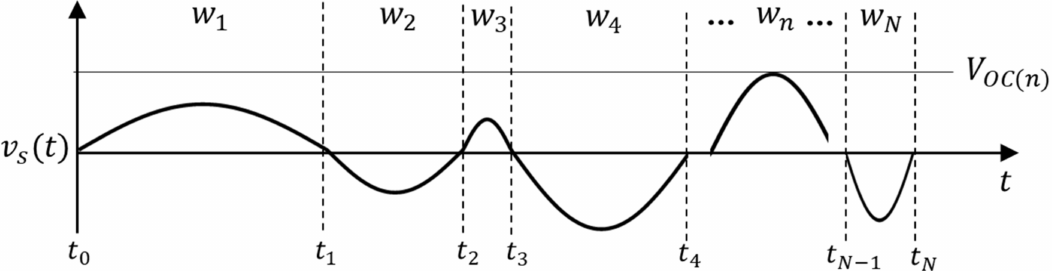
Figure 12. Sinusoidal voltage source